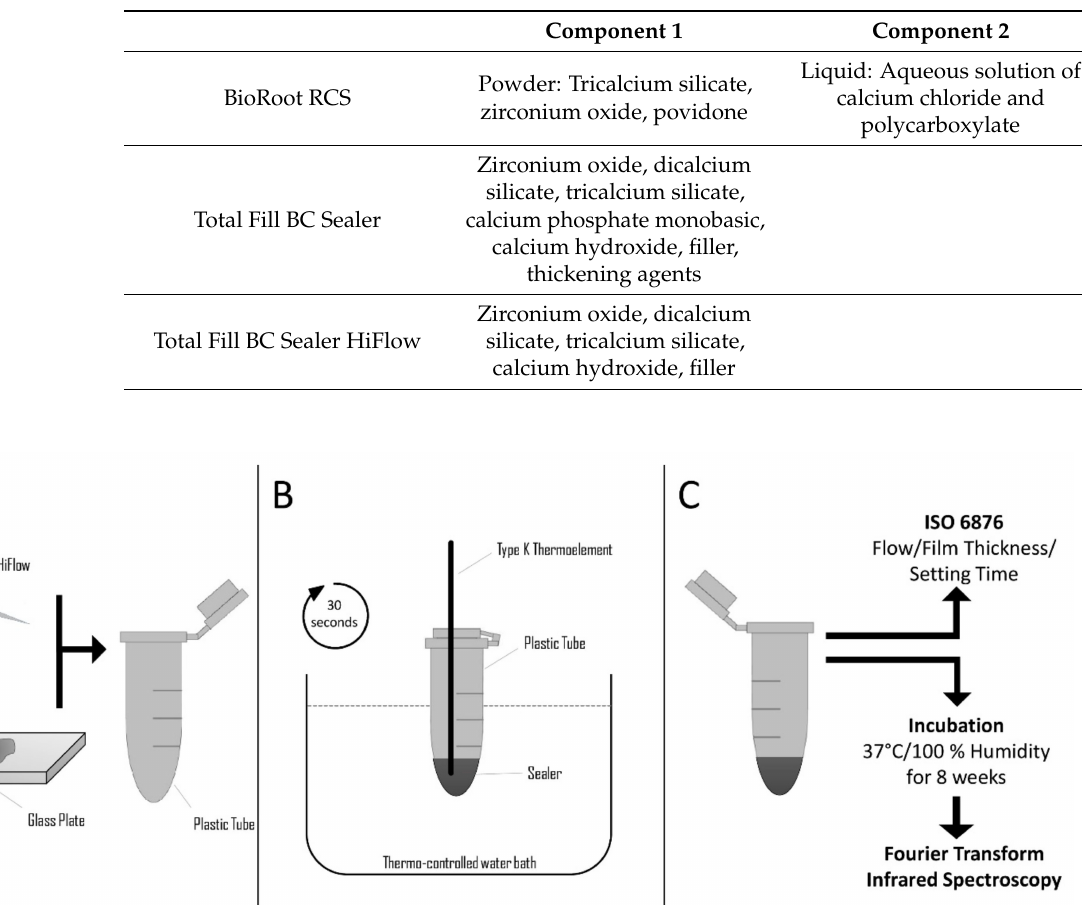
Table 1. Composition of the sealers as provided by the manufacturers.